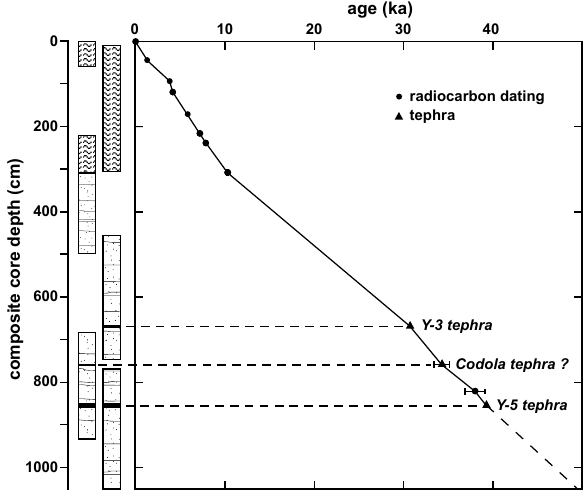
Fig. 3. Age-depth model of core Co1204 based on linear interpo- lation between dated horizons. The ages from tephras and cryp- totephras are indicated by triangles (Sulpizio et al., 2010). The ages from radiocarbon dating of macrofossils are indicated by black dots and were converted in (ka) based on the calibrated ages in Table 1 (factor 10 3 ) . Error bars are given for all tephra and radiocarbon ages according to Tables 1 and 2, but are partly overlain by the triangles and